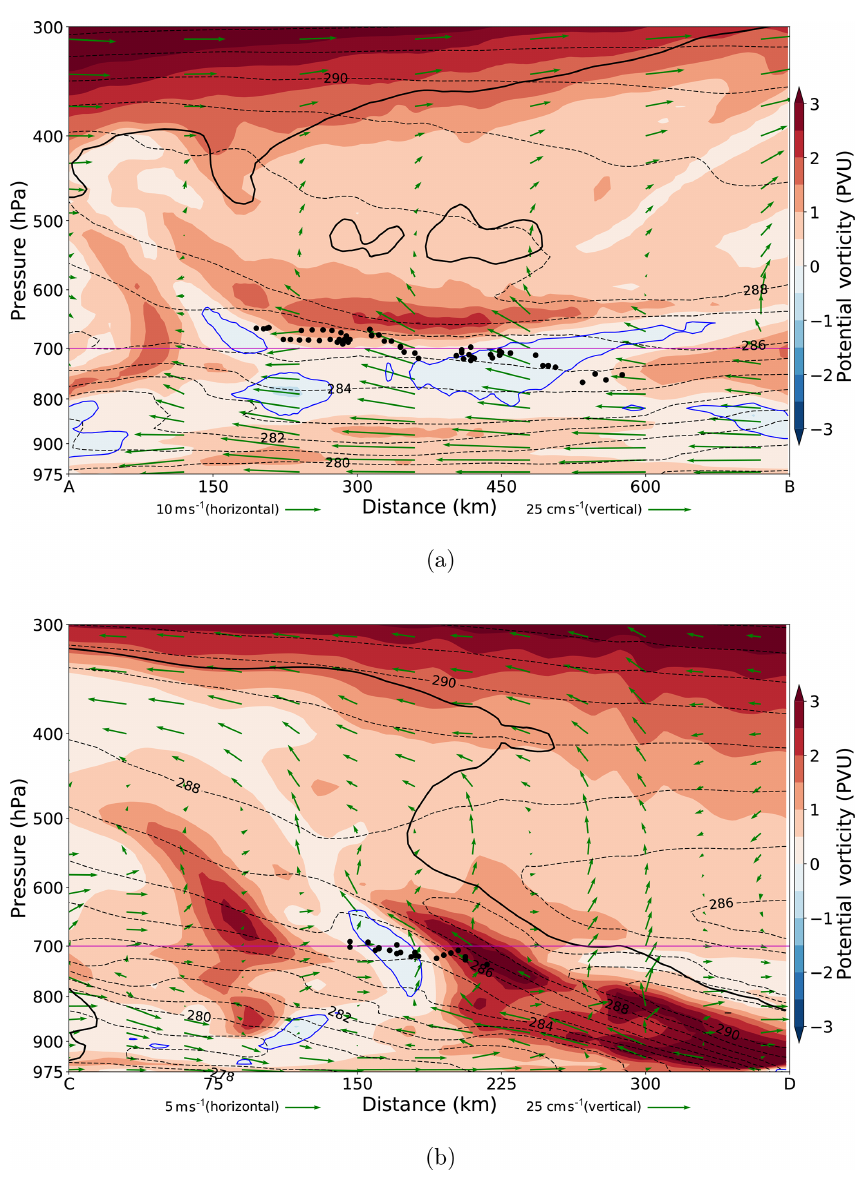
Figure 7. Cross sections on transect (a) AB and (b) CD of Fig. 6a of PV (PVU; shading), θ w (thin black dashed contours; K) and cloudy regions (RH ice = 80%; black bold contours) at 83h from run start. Green wind vectors are constructed using the horizontal wind parallel to the section as horizontal component and vertical velocity multiplied by (a) 48 or (b) 24 as vertical component (see scales beneath panels). This scaling was done to preserve consistency with the section’s aspect ratio. Black dots show the perpendicular projection on the transect of the trajectories that are less than 25km distant from the relevant transect. The magenta line indicates the pressure of 700hPa, to which Fig. 6a